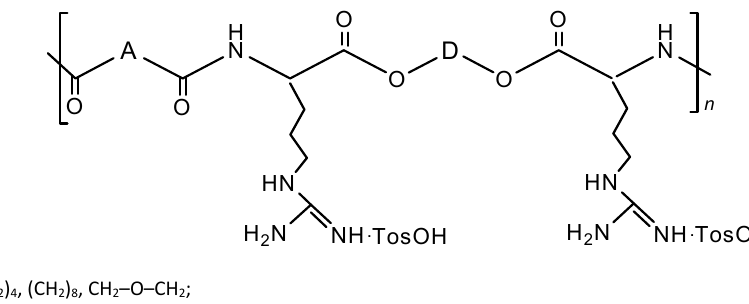
Figure 29. Cationic AABBP composed of L